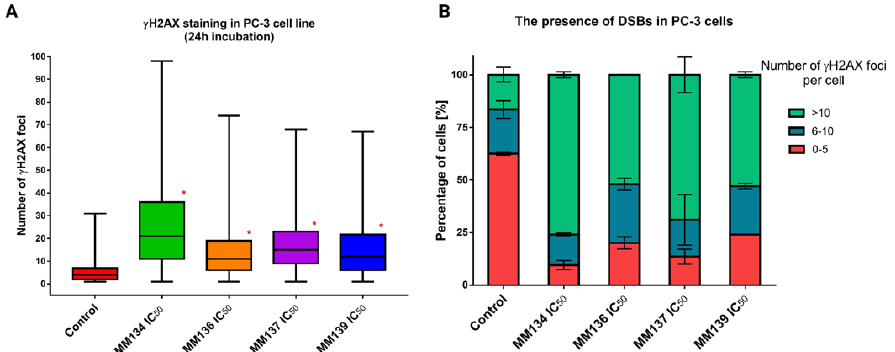
Figure 10. γ H2AX staining results in PC-3 cells: determination of DNA damage (double-strand breaks—DSBs) induced by IC 50 concentrations of MM134 , -6 , -7 , and -9 in PC-3 cancer cell line. ( A ) Data are represented as median γ H2AX foci number per cell in each group with interquartile range and minimal and maximal values. The Kruskal–Wallis test was used to show a statistically significant difference between groups. Multiple comparisons using mean ranks for all groups module of Statistica software were used. In all groups, N > 200. * significant difference compared to the negative control ( p < 0.05). ( B ) The graph presents the mean ( ± SD) percentage of cells that have a defined number of γ H2AX foci in the sample.